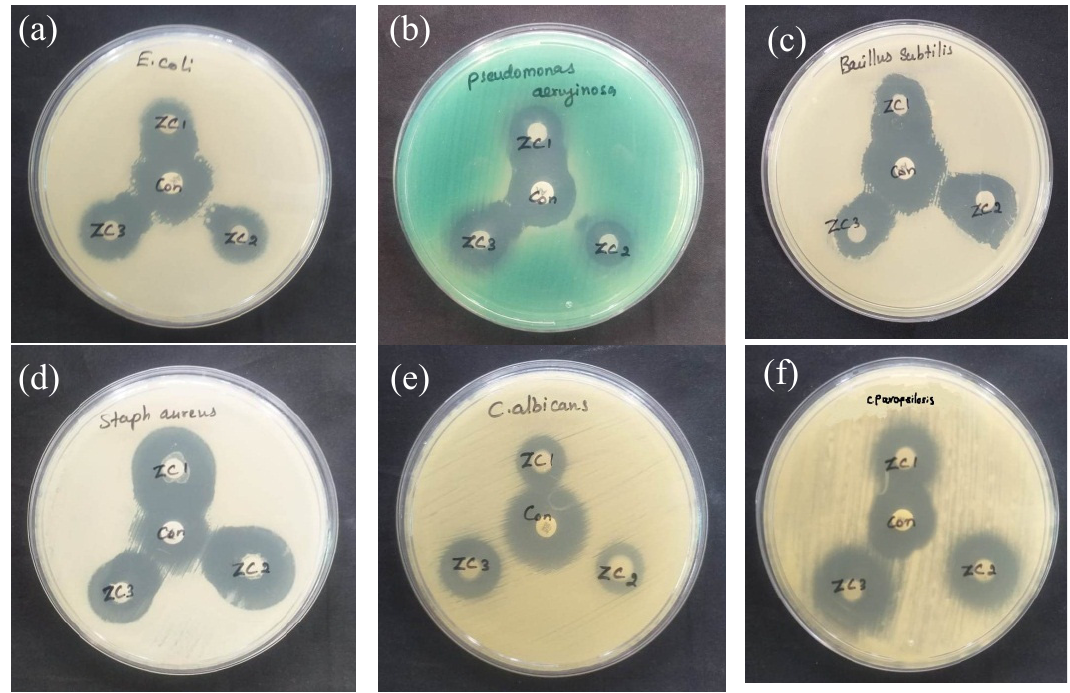
Fig. 11. Anti-bacterial and Anti-fungal effect of Cu doped ZrO